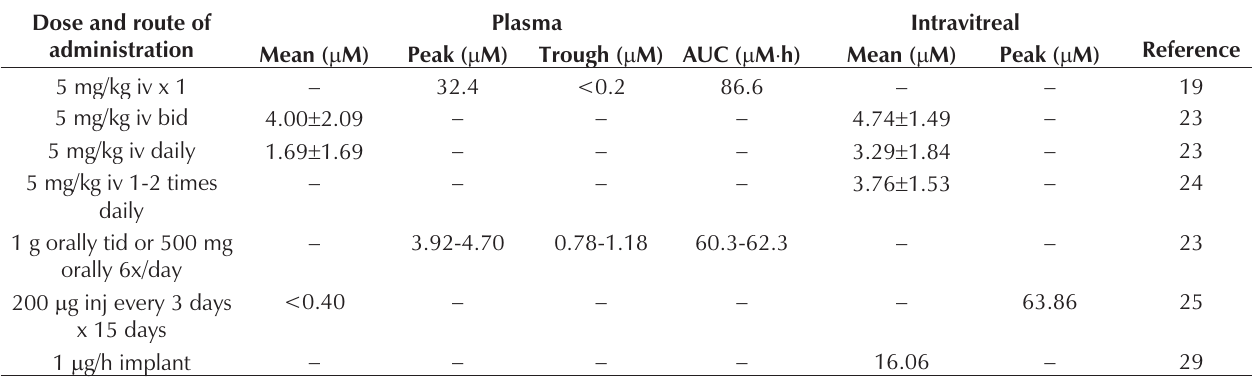
Ganciclovir concentrations Dose and route of administration